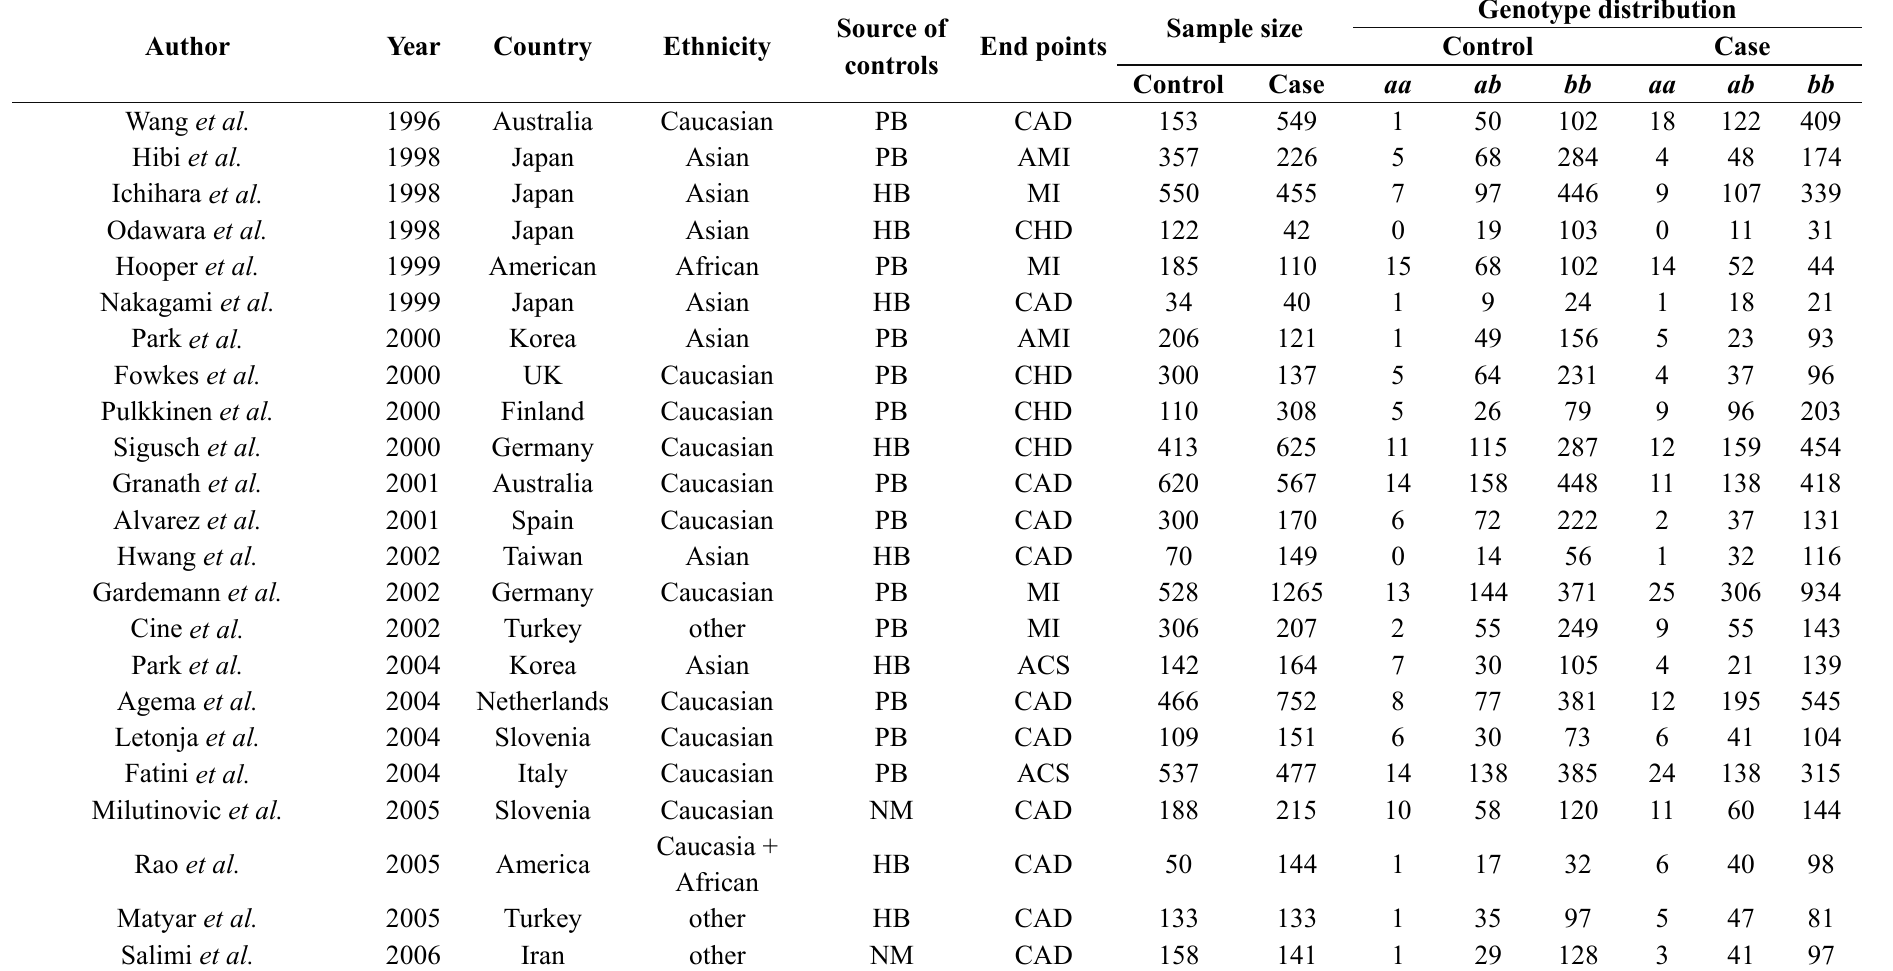
Table 1. Study Characteristics of genotypes in coronary artery disease (CAD) cases and controls in the analysis of endothelial nitric oxide synthase ( eNOS ) 4b/a